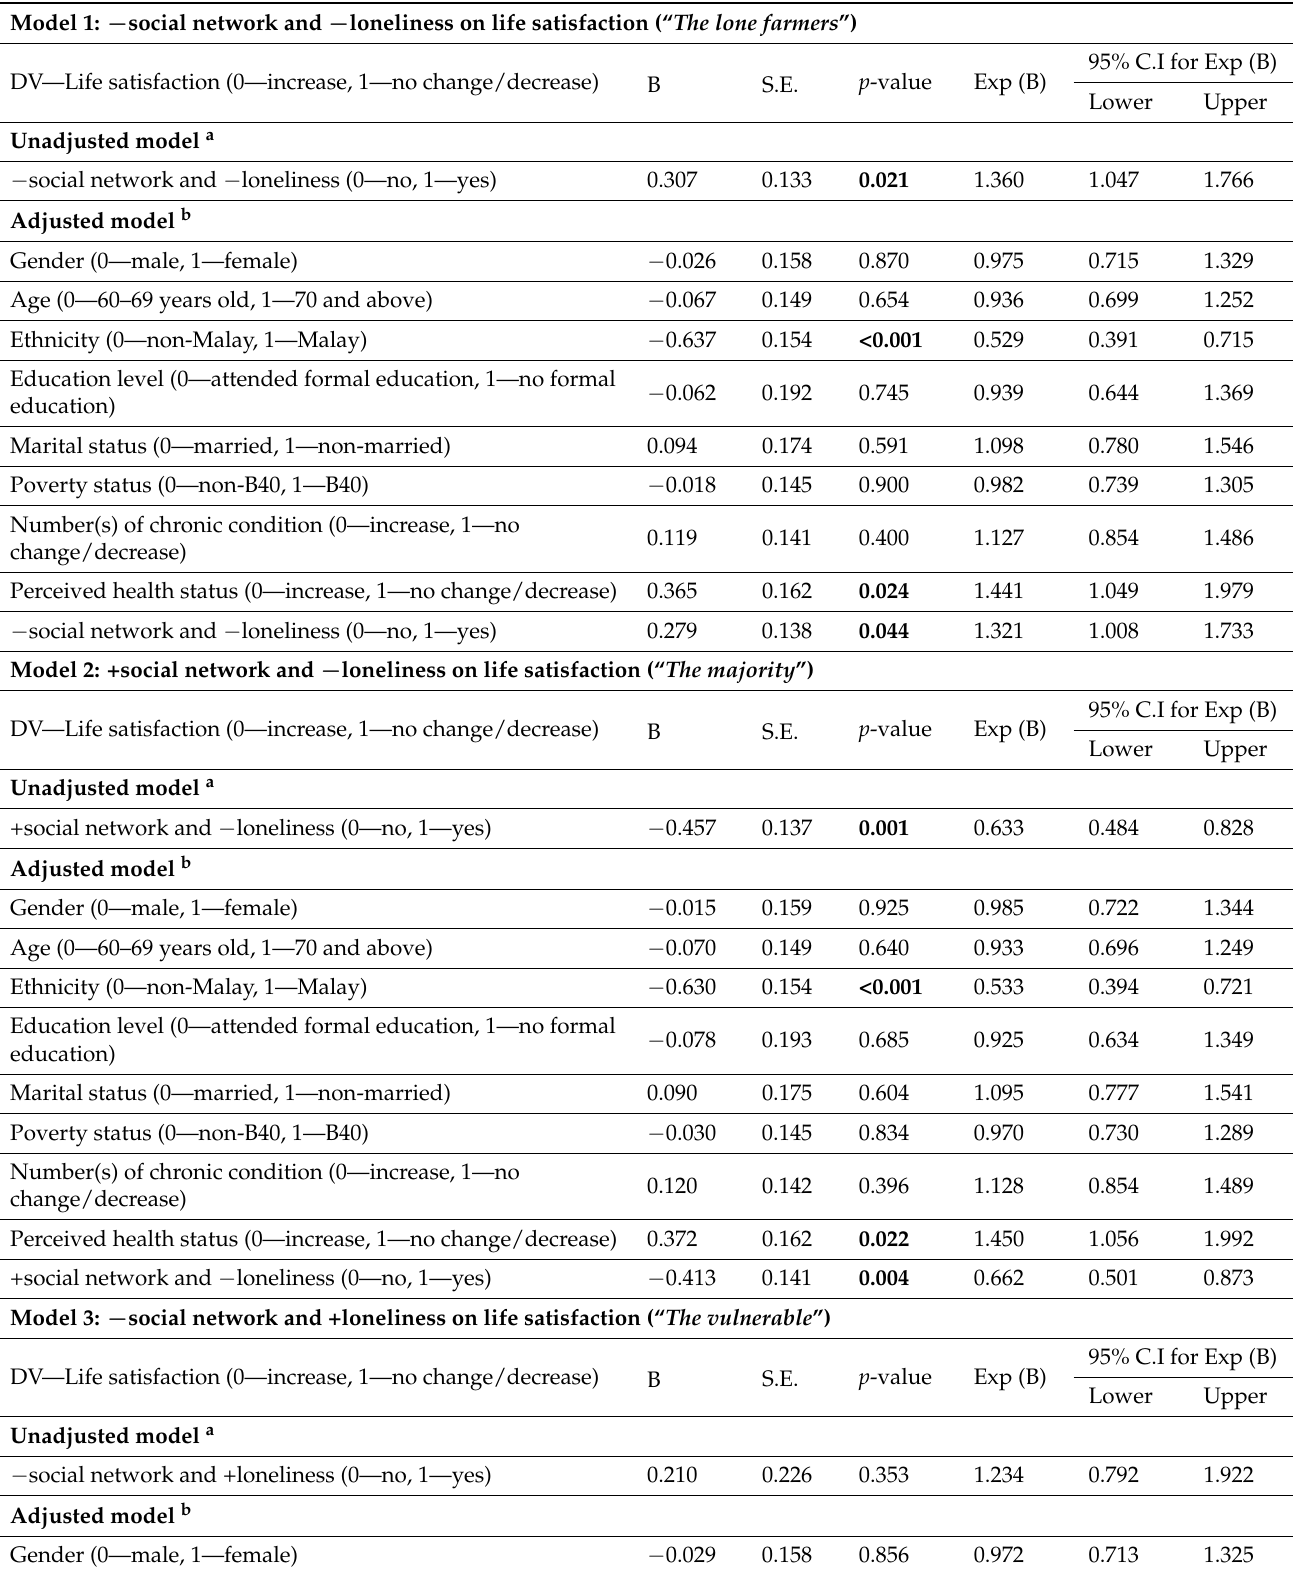
Table 4. Combined effects of social network and loneliness on life